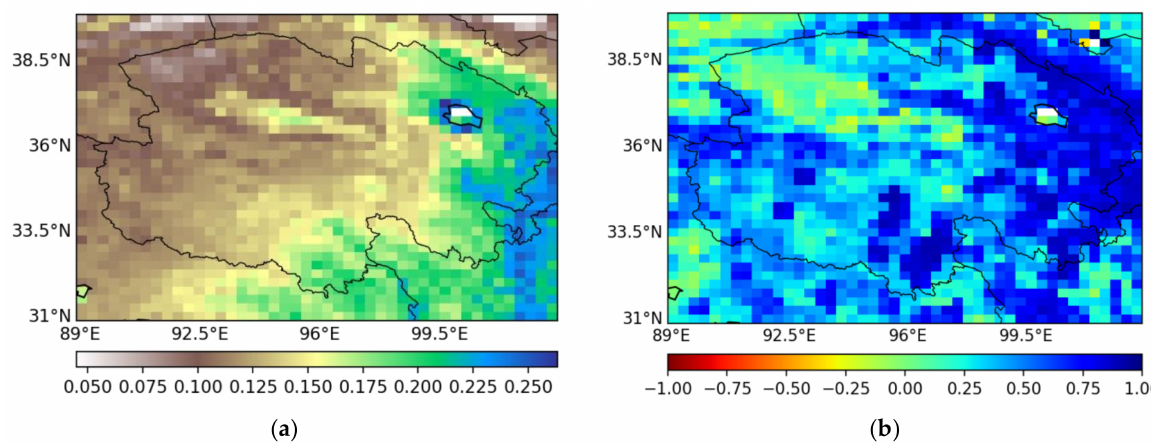
Figure 6. ( a ) Map of daily average soil moisture retrieved by applying the NN to the combination of microwave data and auxiliary inputs NDVI, LST, DEM, SLOPE, and NSDSI. ( b ) Map of temporal correlation between the NN SM data (left side) and CLDAS soil moisture